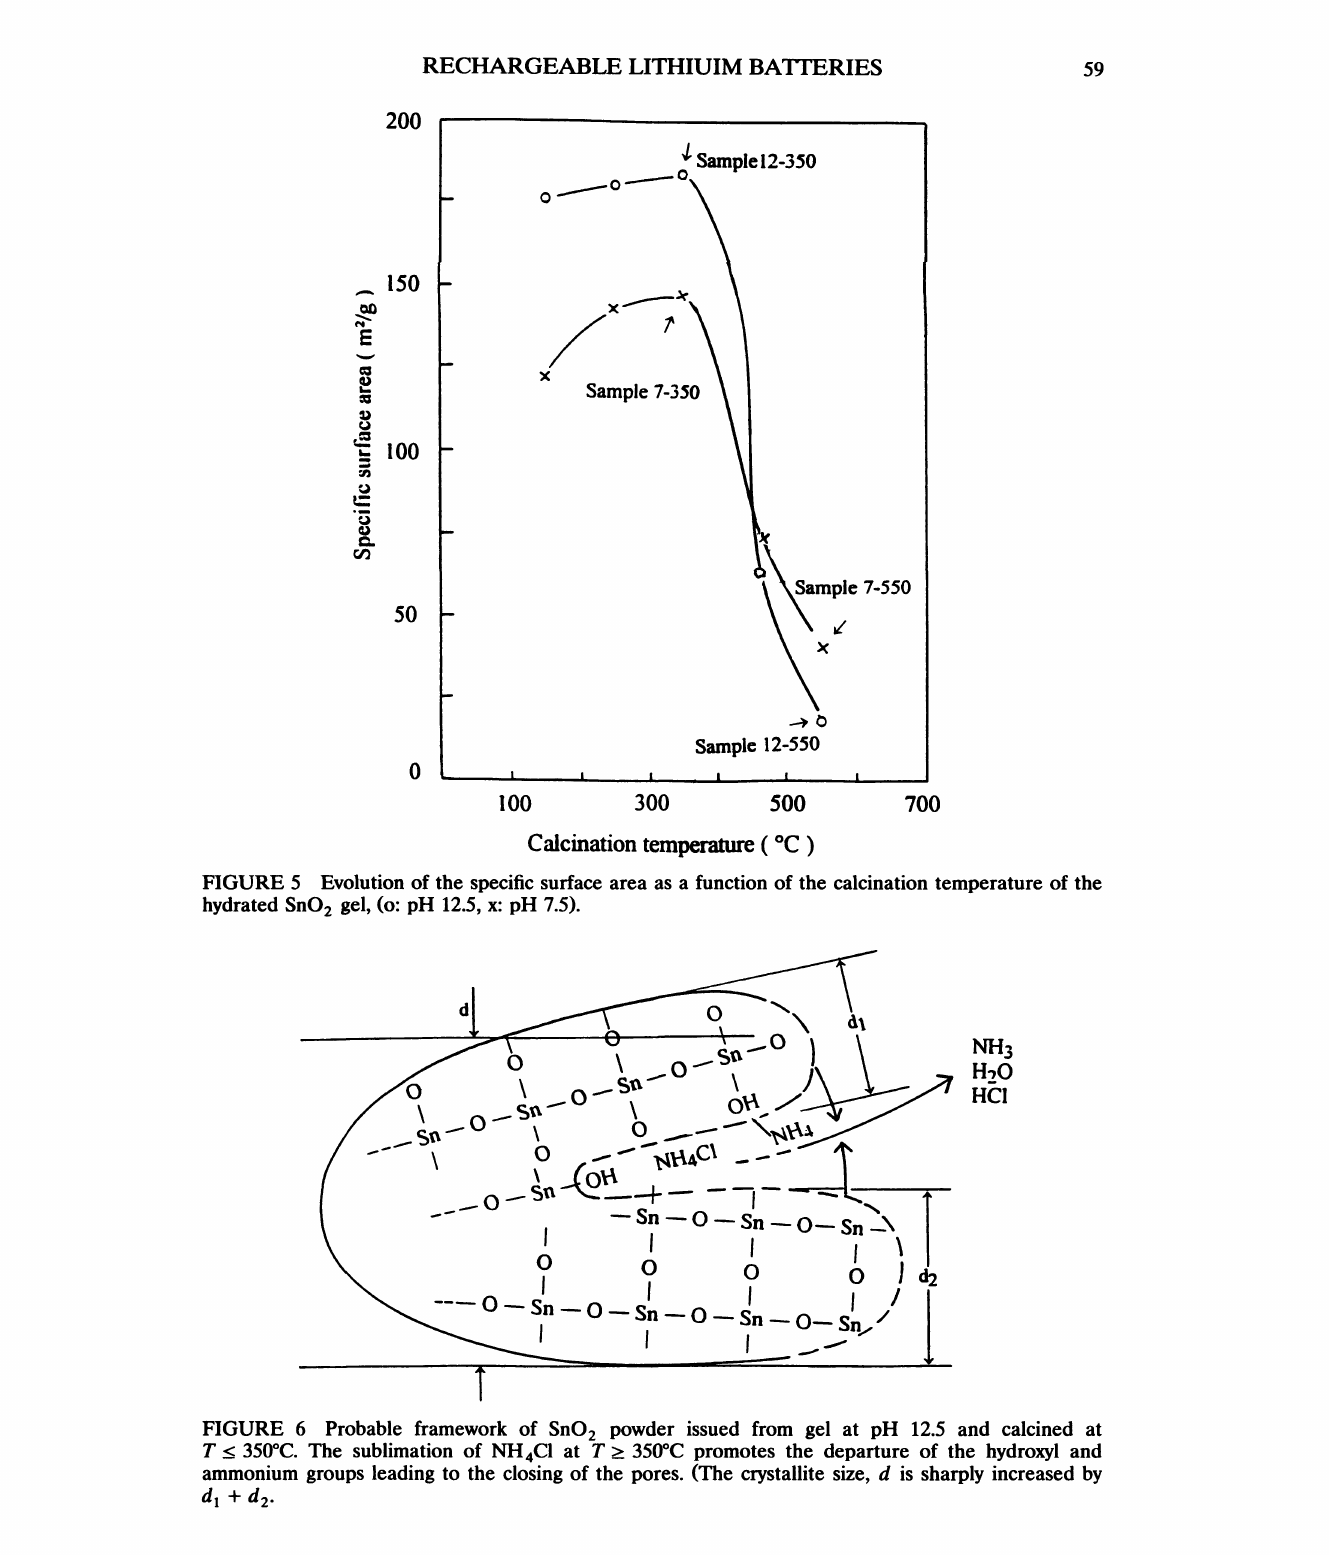
FIGURE 6 Probable framework of SnO powder issued from gel at pH 12.5 and calcined at T _< 350C. The sublimation of NH4CI at T > 350C promotes the departure of the hydroxyl and ammonium groups leading to the closing of the pores. (The crystallite size, d is sharply increased by d + d